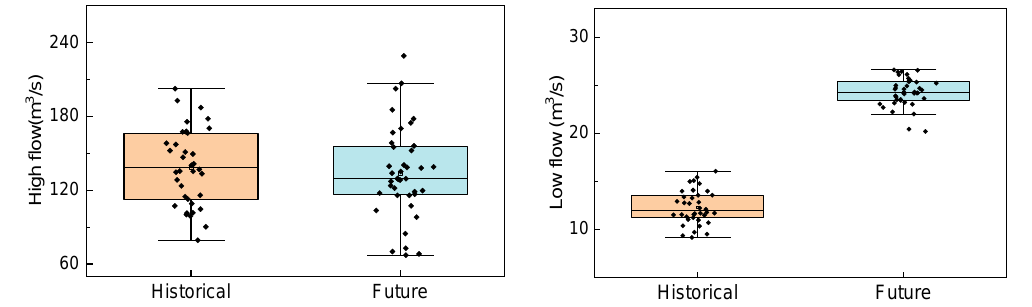
Figure 11. Box plot of historical and future high flows and low flows. Table 4. Statistical values of runoff.